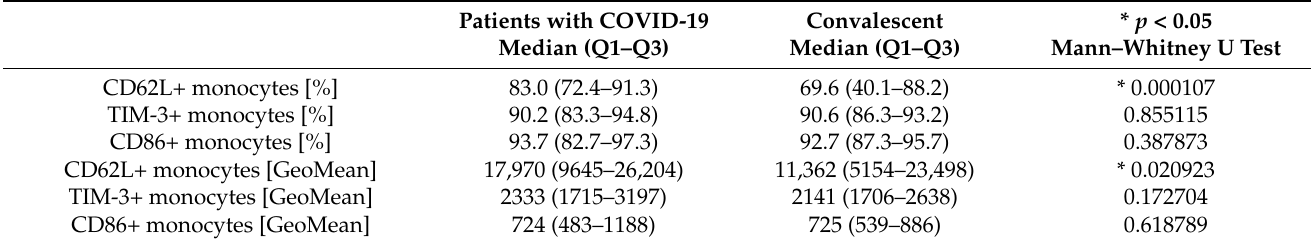
Table 4. Median proportion and median geometric mean expression of TIM-3, CD62L and CD86 markers on monocytes between patients with COVID-19 and convalescent patients with COVID-19. Data expressed as median (Q1–Q3). (* p < 0.05 Mann–Whitney U test).